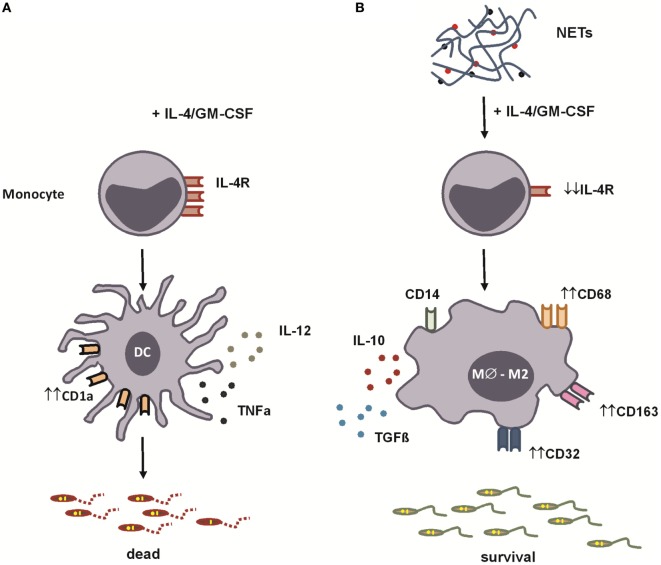
Summary scheme for neutrophil extracellular traps’ (NETs’) blockage of dendritic cells (DCs) differentiation from monocytes. (A) In the presence of IL-4 and GM-CSF, monocytes are stimulated to differentiate into DCs. These cells express CD1a molecules and, when stimulated by lipopolysaccharide (LPS), produce high amounts of pro-inflammatory cytokines [IL-12 and tumor necrosis factor-α (TNF-α)]. (B) We show in this study that NETs, produced by Leishmania amazonensis-activated human neutrophils, downregulate the expression of the IL-4 receptor α chain skewing monocytes to differentiate into anti-inflammatory macrophages. Macrophages differentiated in the presence of NETs express CD68, CD163, and CD32 and, when stimulated by LPS, produce high amounts of interleukin-10 (IL-10) and transforming growth factor-β (TGF-β), favoring Leishmania survival.